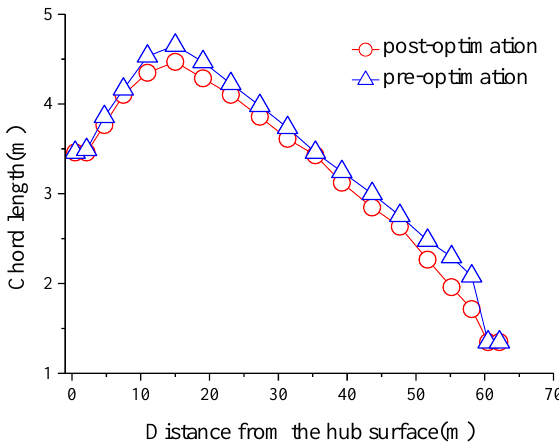
Figure 7. Distribution of the twist angle for fixed wind turbine blade at low wind speed before and after optimization.